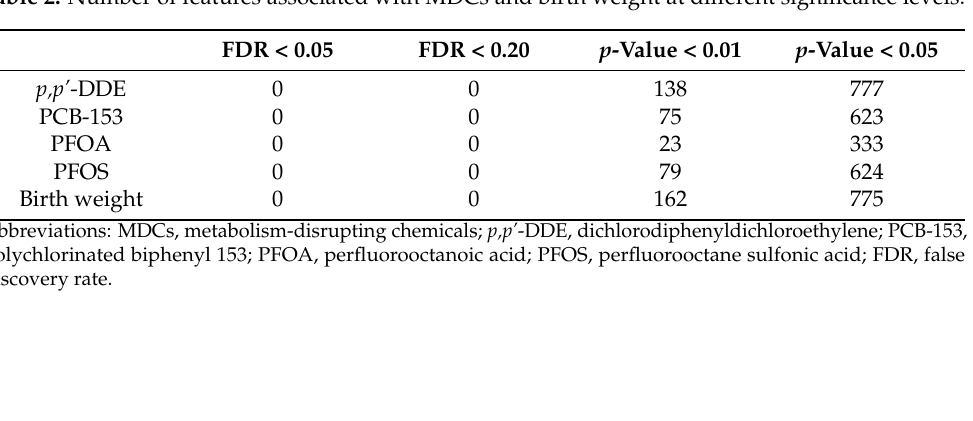
Table 2. Number of features associated with MDCs and birth weight at different significance